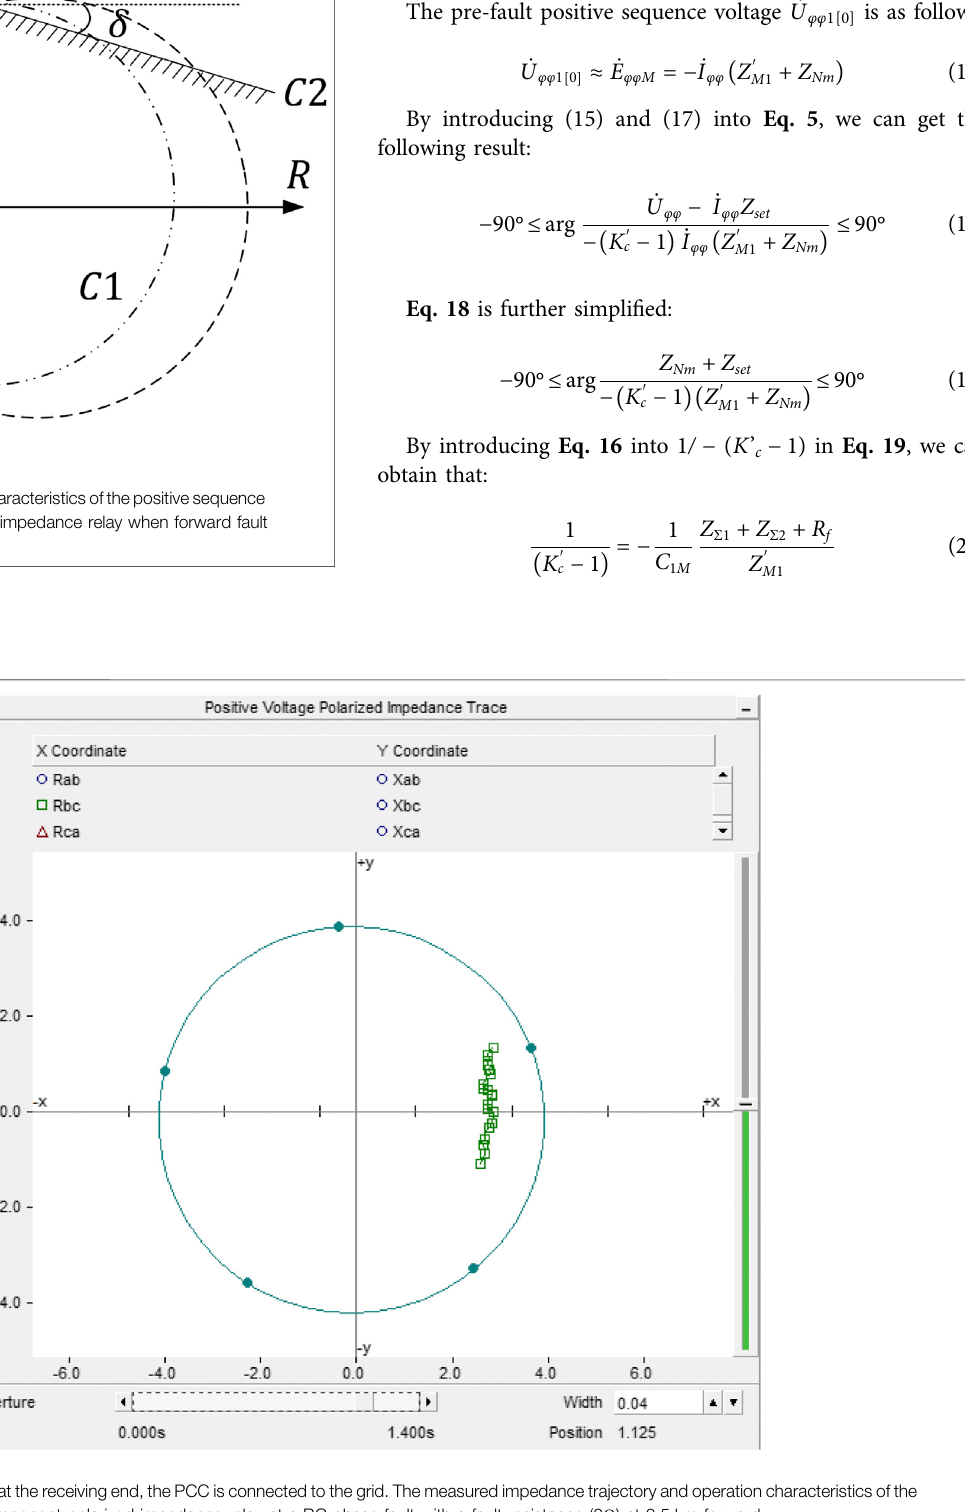
FIGURE5| Whentheprotectionisatthereceivingend,thePCCisconnectedtothegrid.Themeasured impedance trajectoryand operationcharacteristicsofthe positive sequence voltage fault component polarized impedance relay at a BC phase fault with a fault resistance (2 Ω ) at 2.5 km forward.